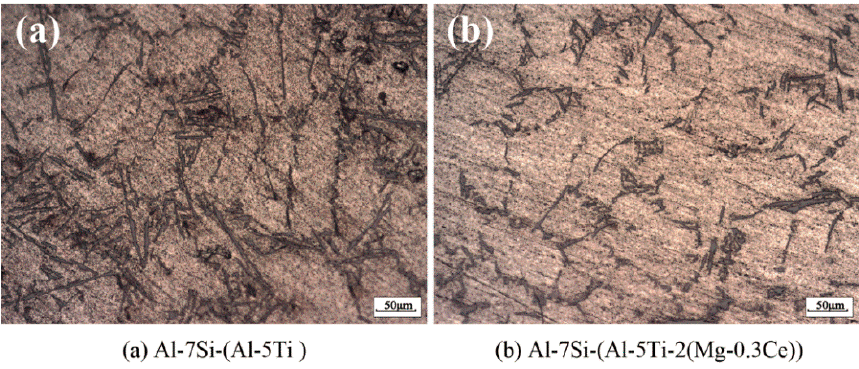
Figure 8. Metallographic microscope image of Al–Si alloy (200×).